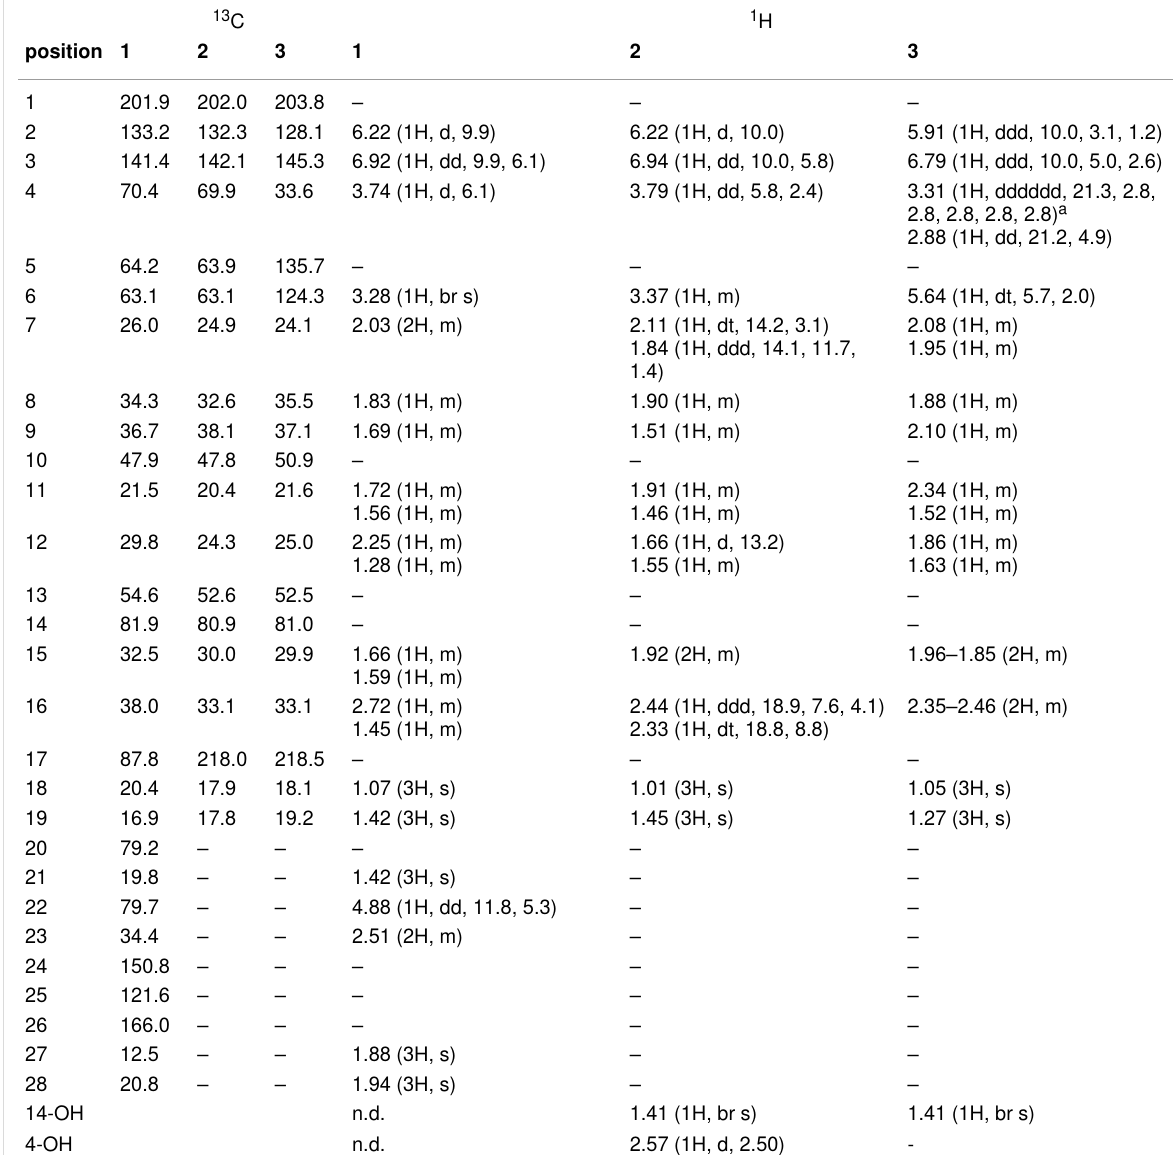
Table 1: 13 C and 1 H NMR data (CDCl 3 , 500 MHz, 298 K) of irinans A ( 2 ) and B ( 3 ) in comparison to the known compound 4 β -hydroxywithanolide E ( 1 , CDCl 3 , 400 MHz, 298 K, δ in ppm, J in Hz). For carbon numbering see Figure 1 and Figure